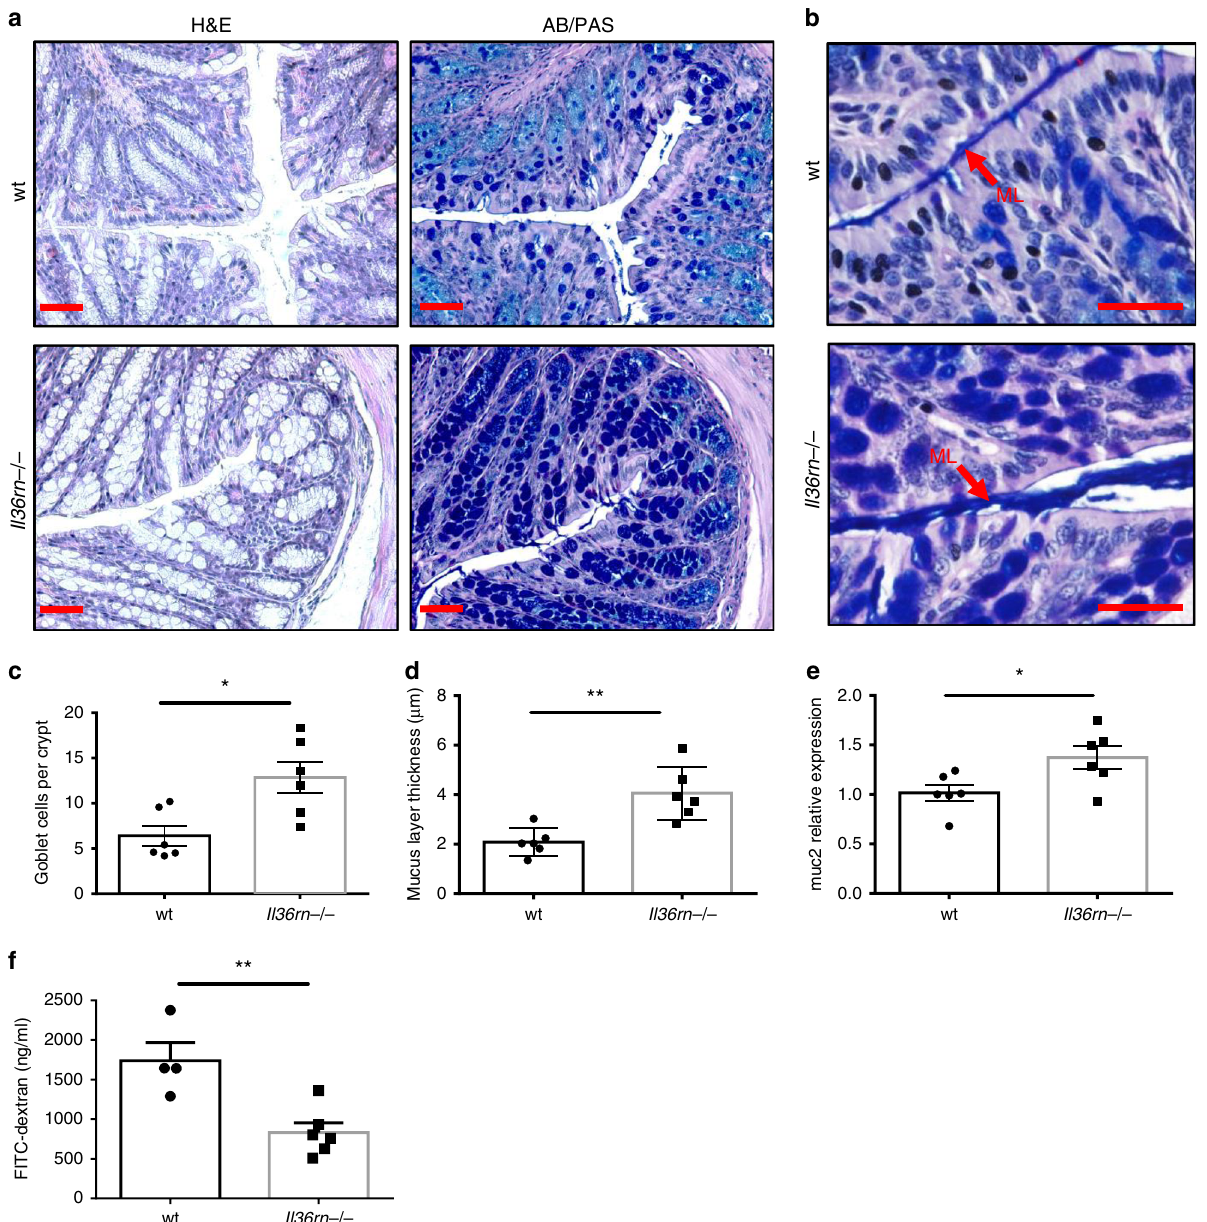
Fig. 5 Increased colon mucus levels and reduced intestinal permeability in Il36rn − / − mice. a Representative micrographs of distal colon sections from wt and Il36rn − / − mice stained with H&E and AB/PAS. Scale bar = 1 μ m. b Representative micrographs of colon sections stained with AB/PAS with mucus layer (ML) indicated by red arrow. Scale bar = 20 μ m. c , d Quantitation of average goblet cells per crypt ( c ) and mucus layer thickness ( d ) in distal colon sections ( n = 6 per group, 10 crypts measured per sample). Data shown representative of three independent experiments. e Relative gene expression of Muc2 gene in the distal colon of wt and Il36rn − / − mice ( n = 6 per group). f Fluorescein isothiocyanate (FITC)-dextran concentration in the serum of wt and Il36rn − / − mice on HFD for 12 weeks, 4 h after oral gavage ( n = 4 and 6 per group). Data show means ± SEM. Statistical analysis using two-tailed unpaired student ’ s t -test. * p < 0.05, ** p < 0.01. Source data are provided as a Source Data fi